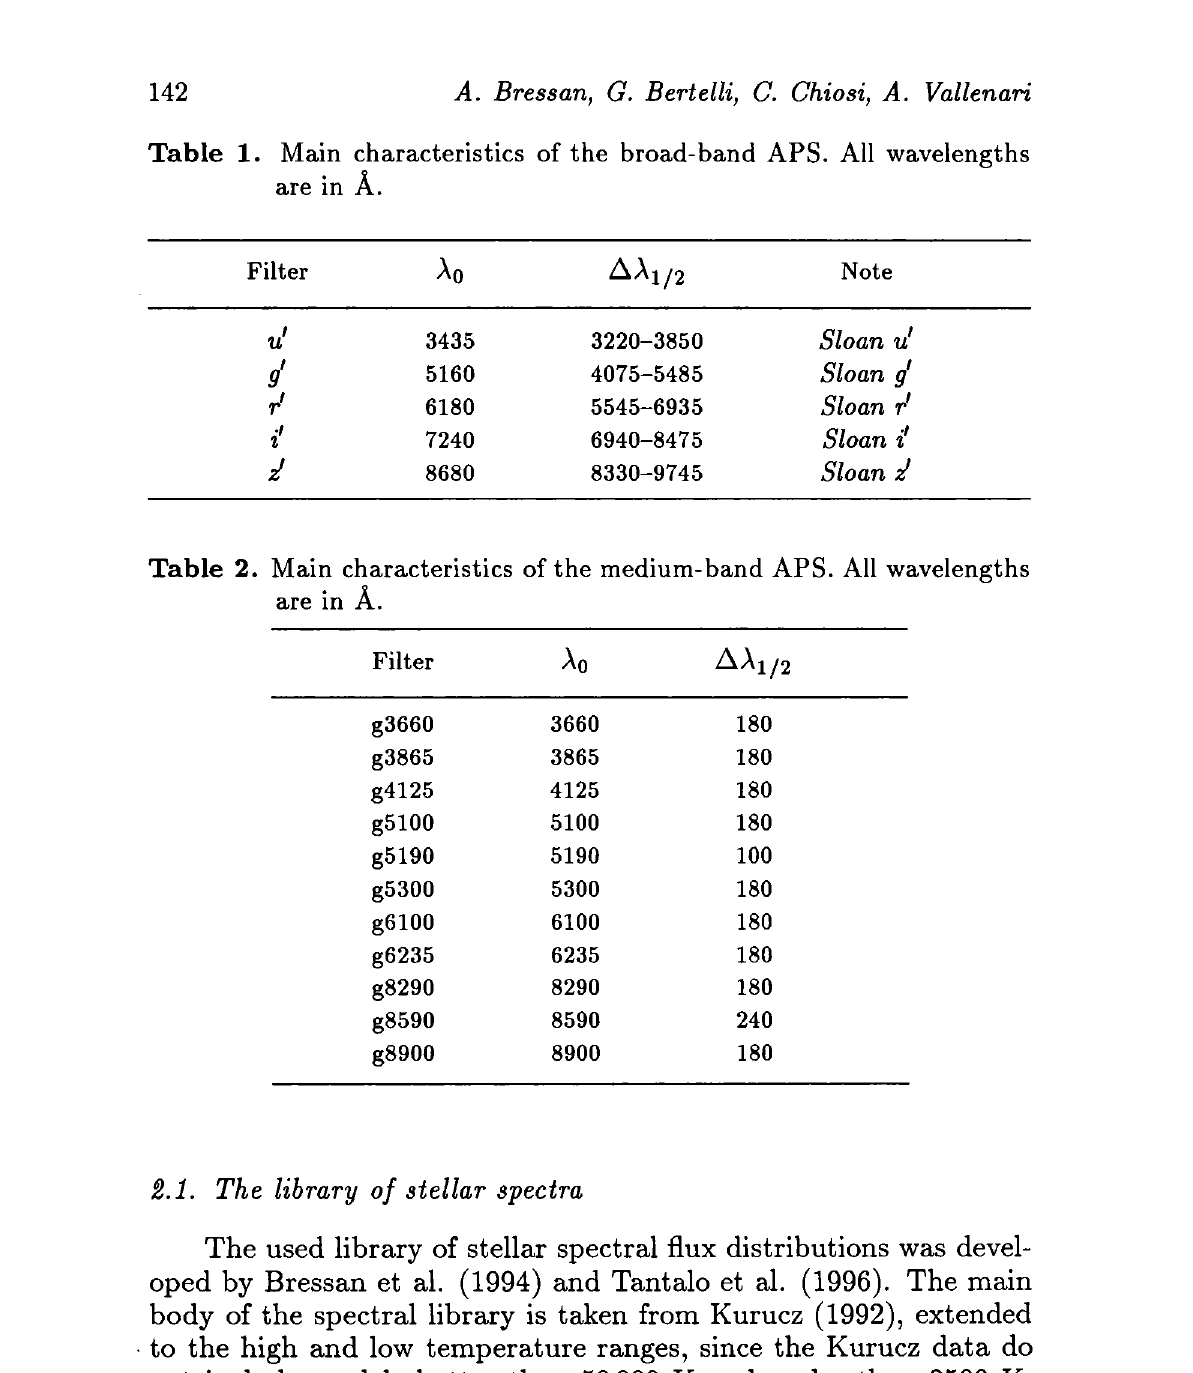
Table 2. Main characteristics of the medium-band APS. All wavelengths are in